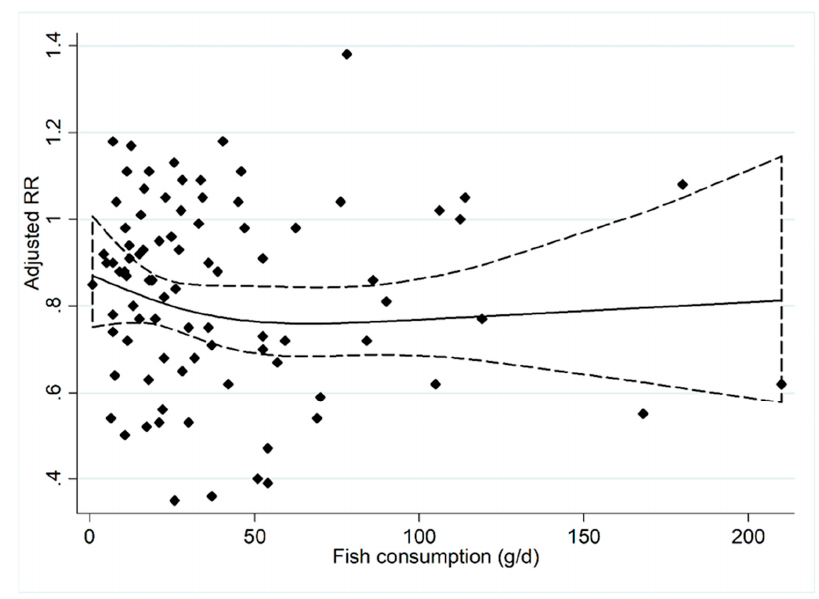
Figure 5. The dose–response analysis between the fish consumption and the CHD mortality. The diamonds represented the adjusted RRs for each exposure quantile of fish consumption in the included individual studies. The solid line and the long dashed line represent the estimated relative risk (RR) and its 95% confidence interval (CI). Abbreviations: g/d, grams per day.